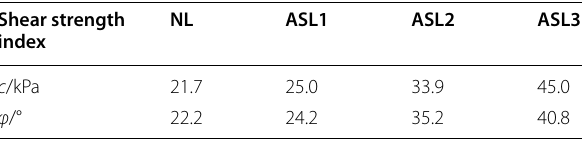
Table 2 Shear strength indices of the samples Shear strength